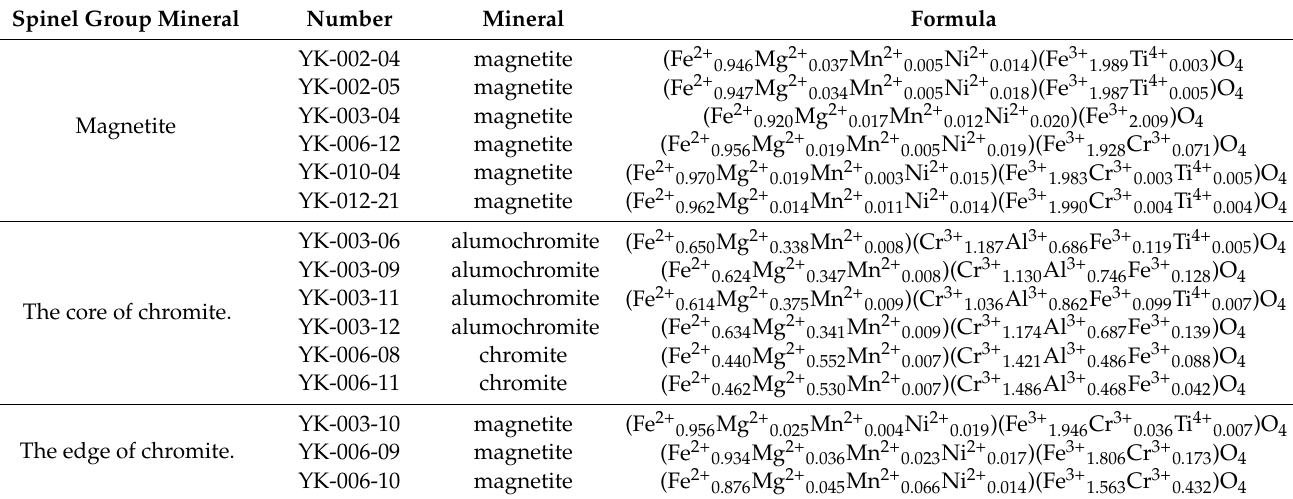
Table 1. Formulas of spinel group minerals in “Laoshan